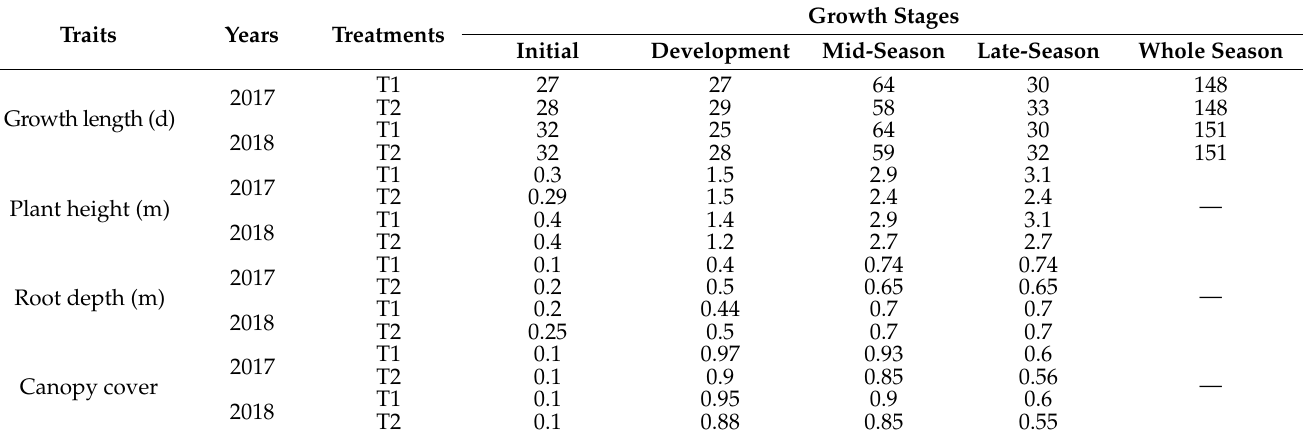
Table 2. Growth traits for two water treatments (T1 and T2) during the whole growth period of maize in 2017 and 2018. Growth Stages Traits Years Treatments Initial Development Mid-Season Late-Season Whole Season Growth length